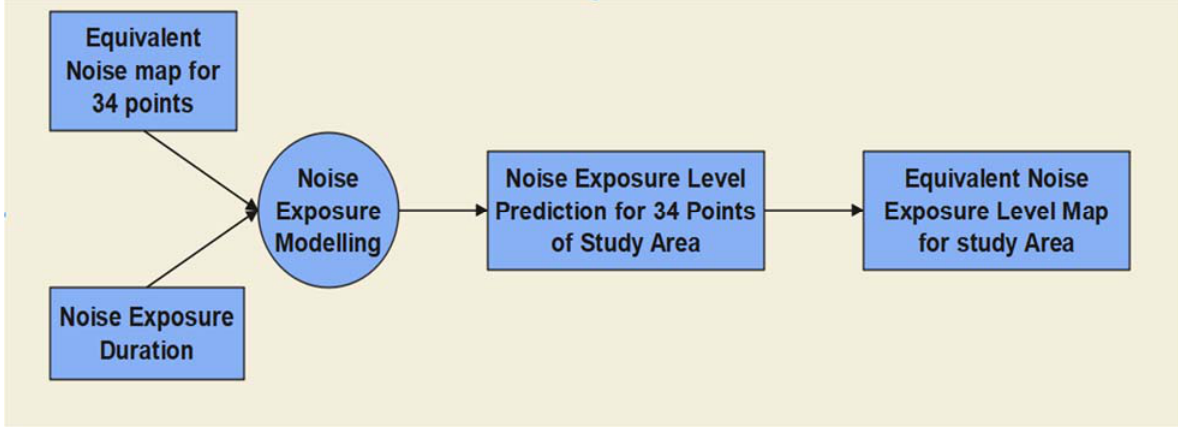
Figure 9. Noise exposure level mapping for noisy bahadurpur intersection for the people working in roadside shops for 10 hours daily.